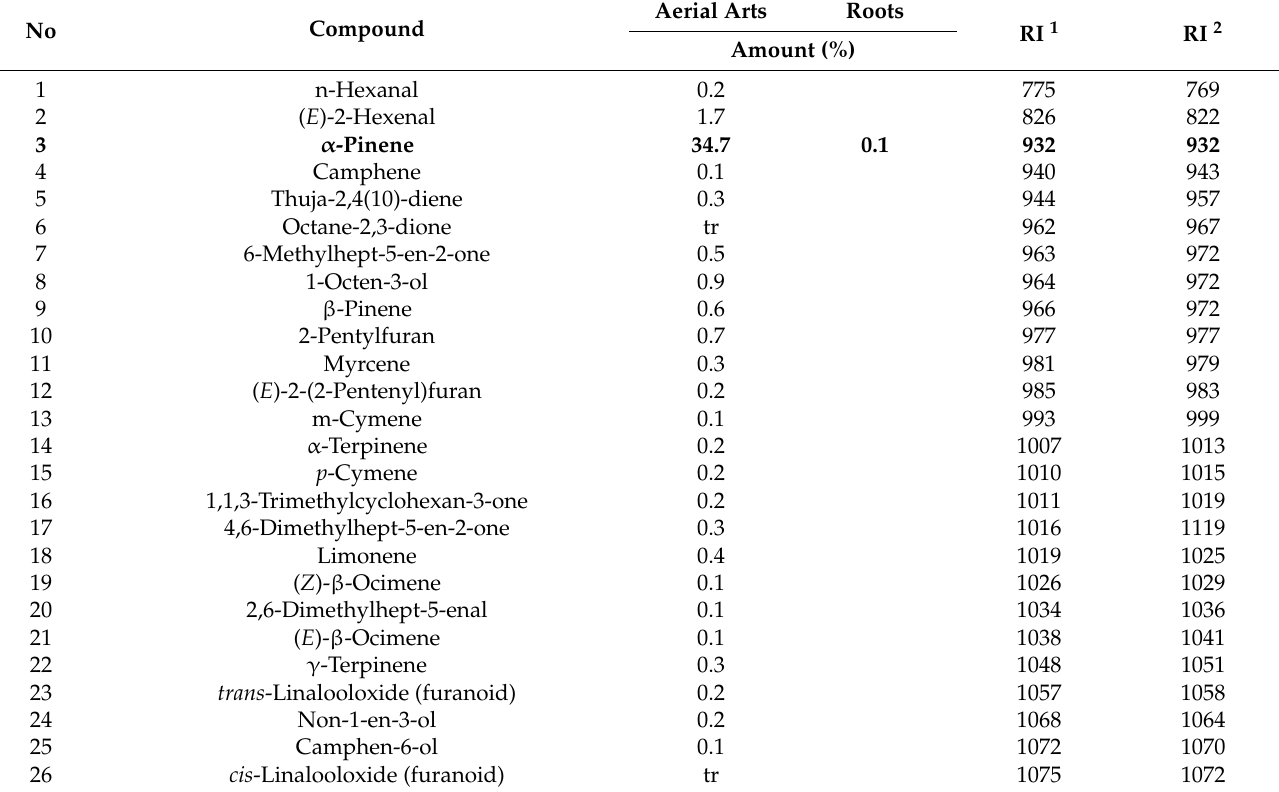
Table 1. Chemical composition of essential oils from aerial parts and roots of Carpesium cernuum